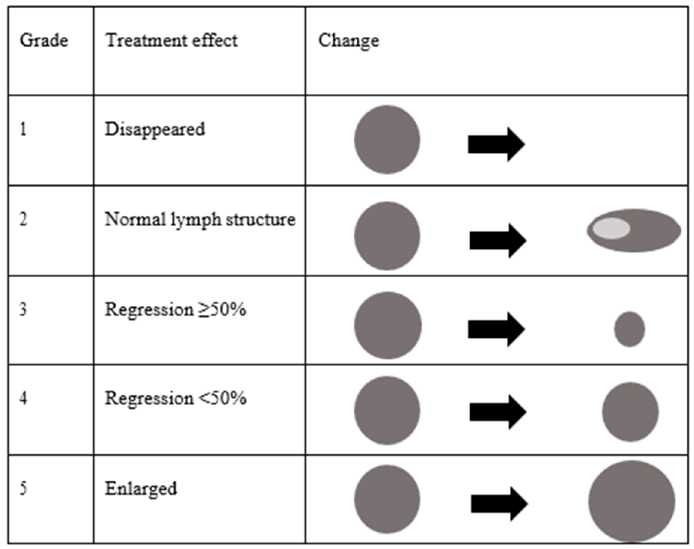
Figure 2. Classification of size change on ultrasonography after